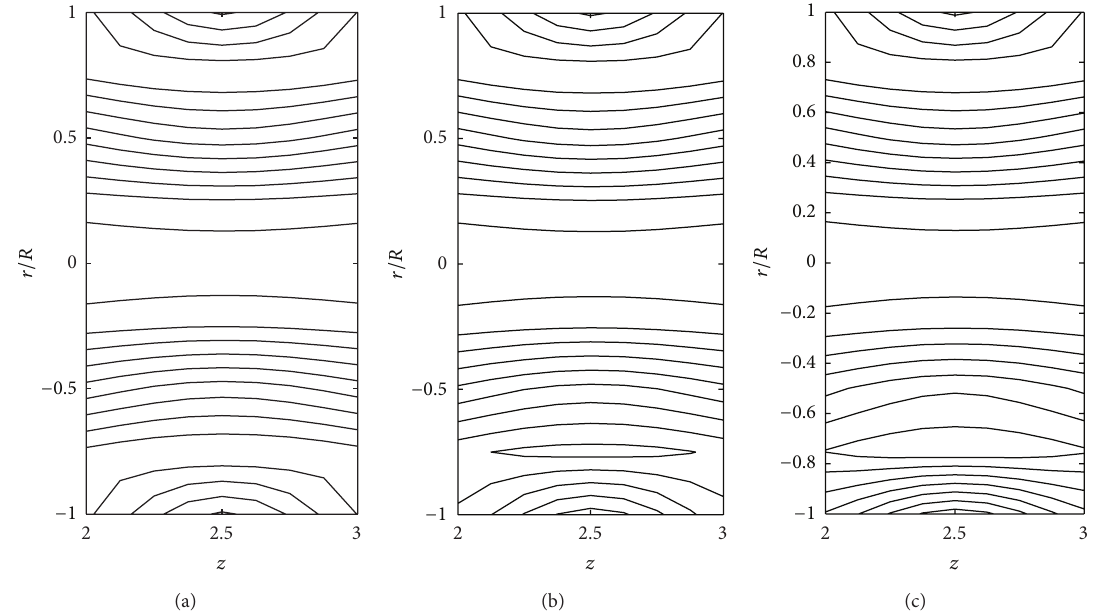
Figure 14: Stream lines for (a) Newtonian fluid, (b) Bingham-plastic fluid ( 𝜏 𝑦 = 0.1 ), and (c) Bingham-plastic fluid ( 𝜏 𝑦 = 0.4 ) taking 𝛿 1 = 0.2 and 𝜁 = 0.01 in the stenotic region.